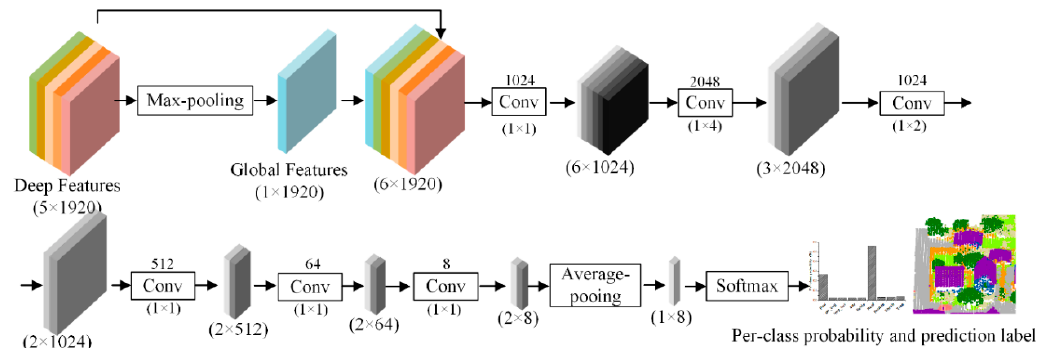
Figure 6. Point cloud classification based on the fully convolution neural network with pooling and convolutional layers (the Conv in the figure represent a convolutional layer, the number above Conv represents the number of the convolution kernel and the number under Conv represents the size of the convolutional kernel).